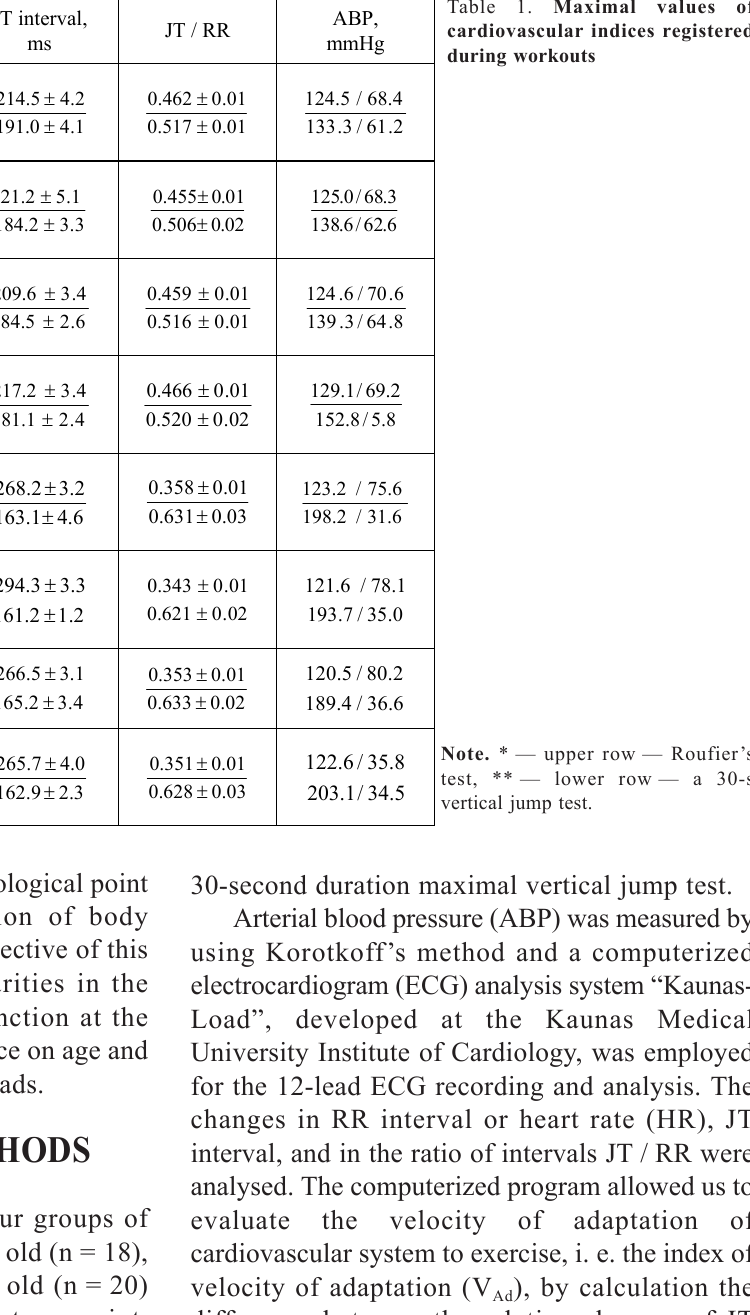
Table 1. Maximal values of cardiovascular indices registered during